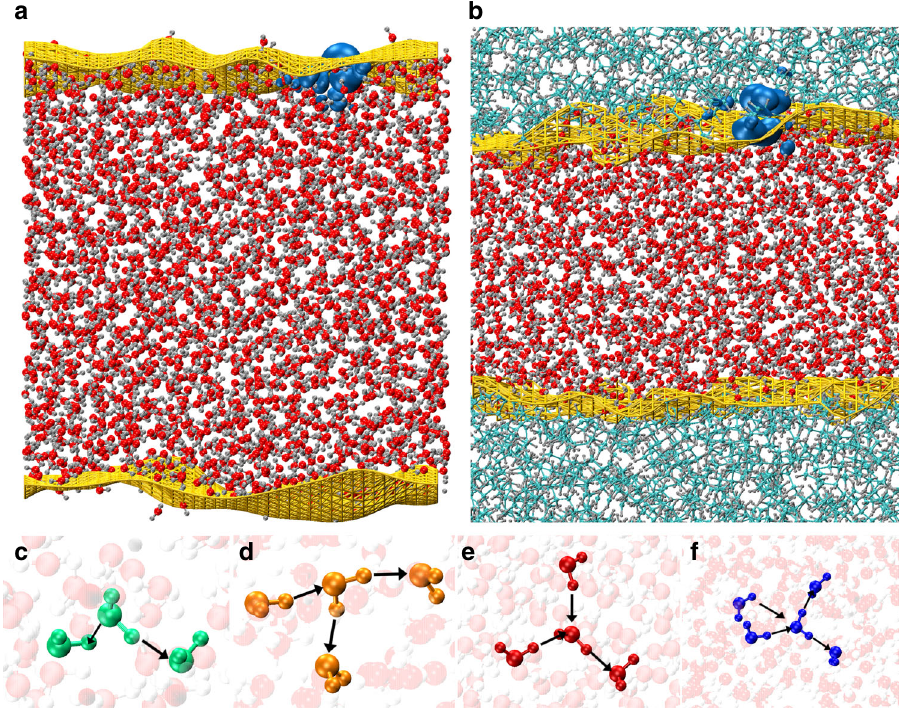
Fig. 1 Simulated systems and coordination defects. Outline of the two simulated systems: a the air – water and b the oil – water. The Willard – Chandler instantaneous surfaces are highlighted in yellow. The highest occupied molecular orbital (HOMO) in both systems is highlighted in cyan. c , d , e , f represent the different types of water molecules coordination con fi gurations that will form the focus of our discussion later. For each coordination con fi guration the accepted hydrogen bond(s) are represented by an arrow pointing in, whereas the donated hydrogen bond(s) are shown by an arrow pointing out. For brevity, the following nomenclature will be used in the rest of the paper: donated hydrogen bonds will be called out, whereas accepted hydrogen bonds will be called in. In this way, c , d , e , f represent, respectively 1in-1out, 1in-2out, 2in-1out, and 2in-2out water coordination con fi gurations.